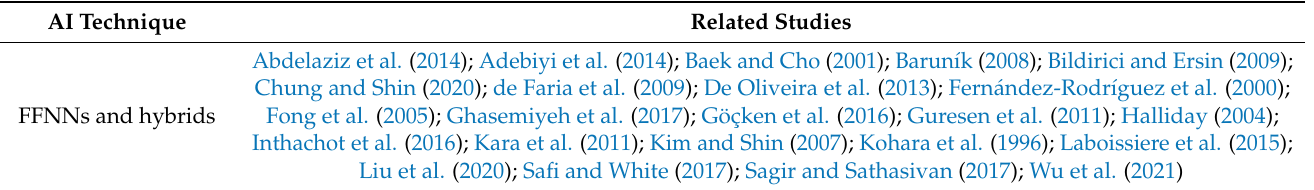
Table A4. Artificial intelligence